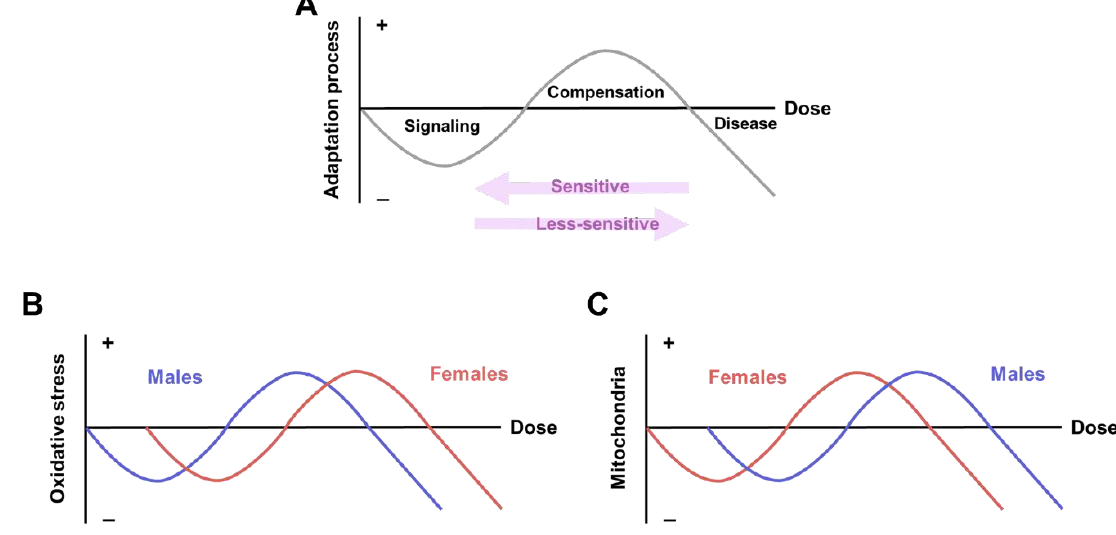
Figure 5. Metabolic adaptation and compensation process. ( A ) Process of metabolic adaptation. ( B ) Adaptation process of oxidative stress, which is sensitive in males. ( C ) Adaptation process of mitochondria, which is sensitive in females.